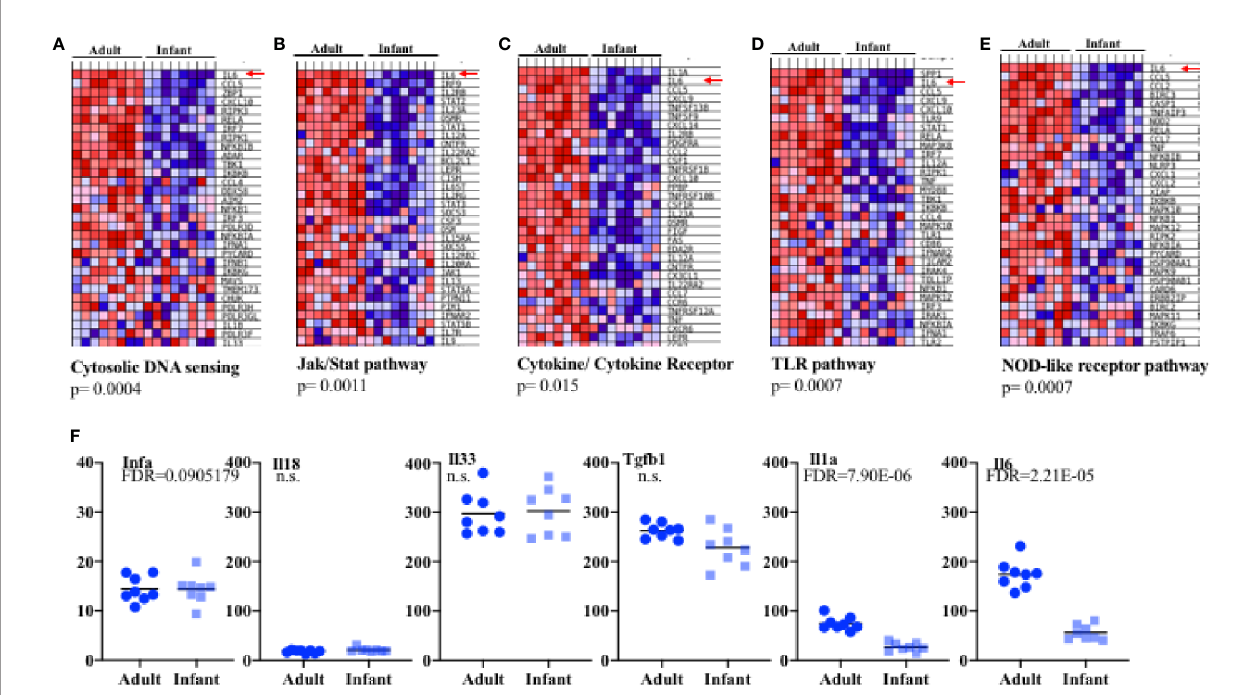
FIGURE 3 | Expression pro fi ling in epithelial cells from infant and adult mice reveals IL-6 de fi ciency at baseline. Four samples each consisting of pooled epithelial cells from the lungs of three male pups or three female pups aged 14 days (total eight pups samples) or epithelial cells from four individual male and four female adult (8 weeks) lungs (eight adult samples total) were used to isolate RNA and examined by array transcriptome pro fi ling. Gene Set Enrichment Analysis (eight total pools per group) revealed signi fi cant differences in expression in pathways relevant to innate immunity. (A – E) Shown are heat maps for the most highly differentially expressed genes within in the various pathways. Red-up regulated, blue down regulated. Red Arrows: IL-6. P values for the gene sets were computed by permuting the gene sets 1,000 times. (F) Transformed RMA data for speci fi c genes in infant versus adult epithelial cell pools. Each symbol refers to a pool of 3 mice. FDR, fold discovery rate (re fl ecting comparison of groups of pools with modi fi cation for multiple comparison testing as part of the array analysis) was calculated using Partek Suites Genomics ® 6.6 Beta